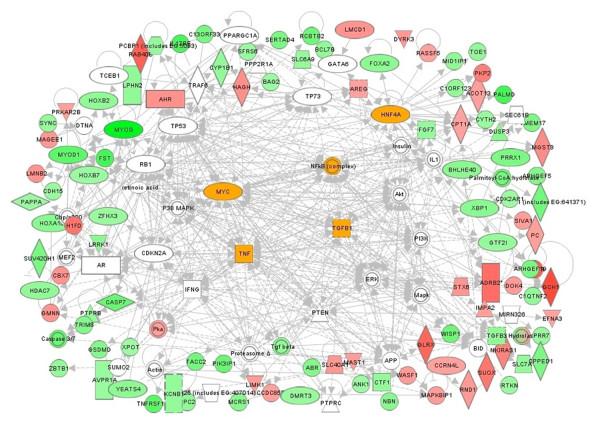
Major gene networks specifically modulated by TSA at 6h. The IPA merged the top seven networks of TSA-elicited genes into a single network. The dominant nodes of TGFβ, HNF-4A, TNFα and MYC connected extensively to the signaling node of NFkB are highlighted. The major gene networks are either directly (solid lines) or indirectly (broken lines) connected to PI3K- and MAPK-specific signaling pathways. The up regulated genes are shown in pink and red while down-regulated genes are depicted in green.